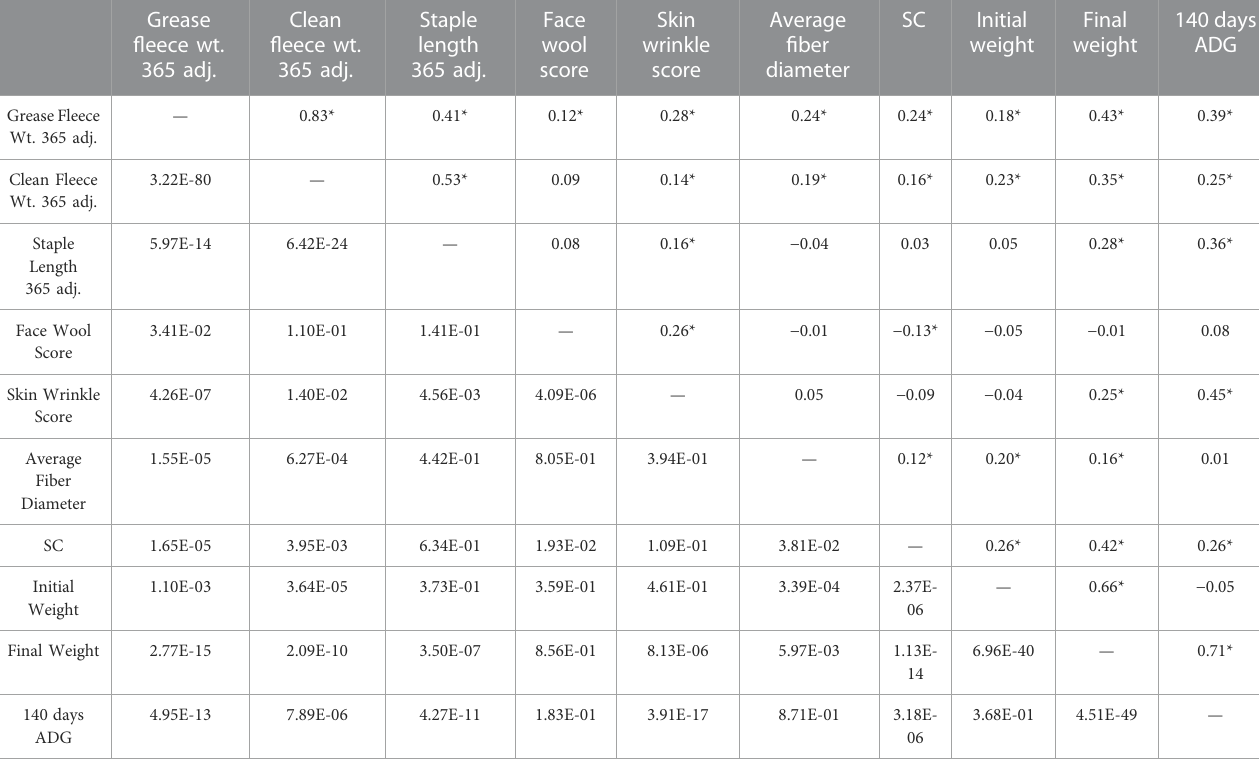
TABLE 3 Pearson correlation results for ram production and wool characteristics. Correlation coef fi cients ( r ) are reported on the upper diagonal and p -values are reported on the lower diagonal. Grease fl eece wt.